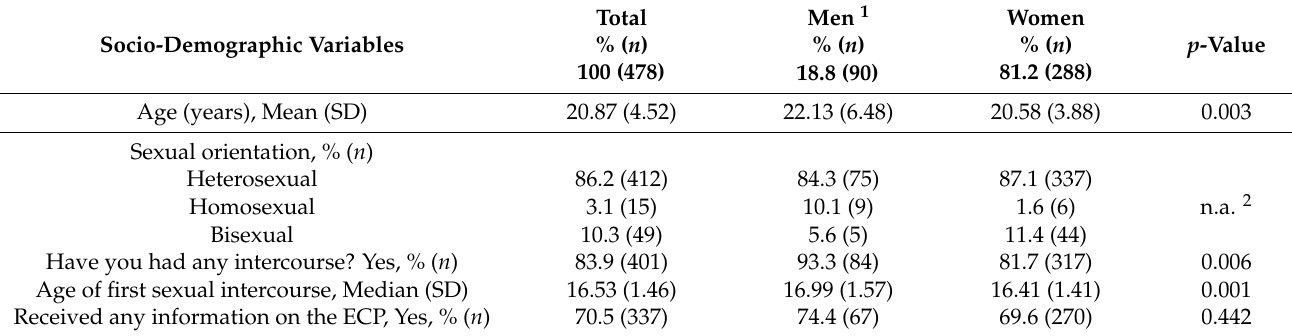
Table 1. Socio-demographic